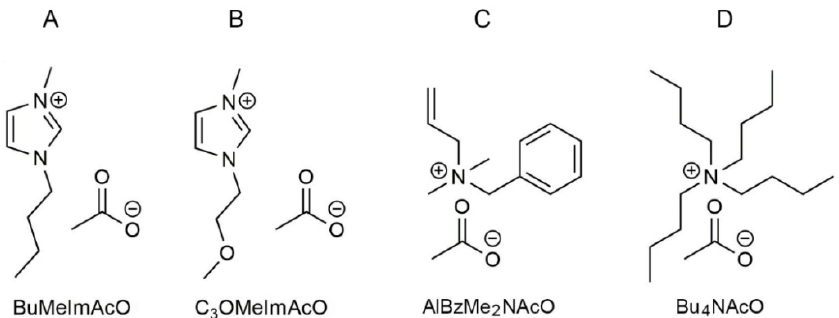
Figure 2. Molecular structure of the ionic liquids employed in the present work: 1-( n -butyl)-3-methylimidazolium acetate (BuMeImAcO) ( A ), 1-(2-methoxyethyl)-3-methylimidazolium acetate, (C 3 OMeImAcO) ( B ), allylbenzyldimethylammonium acetate (AlBzMe 2 NAcO) ( C ), and tetra( n -butyl) ammonium acetate (Bu 4 NAcO) ( D ).